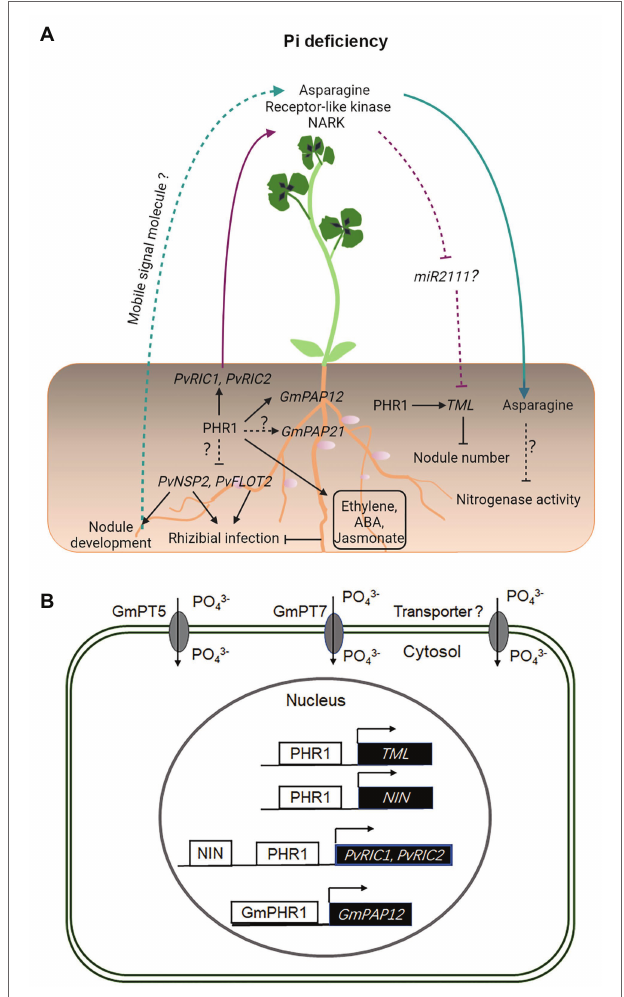
FIGURE 2 | Legume–rhizobium symbiotic signaling under inorganic phosphate (Pi) deficiency. Under Pi deficiency, the expression of PvNSP2 and PvFLOT2 is inhibited, resulting in compromised rhizobial infection and nodule development (A) . Pi deficiency induces the expression of GmPAP21 and GmPAP12 , the latter of which is directly regulated by GmPHR1 (A,B) . Pi deficiency also activates ethylene, abscisic acid (ABA), and jasmonate-related signaling processes, which inhibit rhizobial infection in Phaseolus vulgaris (A) . The expression of NIN , RIC1 , RIC2 , and TML is directly activated by PHR1 in P. vulgaris under conditions of Pi deficiency (A,B) . PvRIC1 and PvRIC2, two CLE-like peptides, negatively regulate the nodule number via the LRR-RLK, NARK-dependent AON pathway (A) . It has not been shown whether miR2111 is involved in this process (A) . Under Pi deficiency, the N-compound asparagine is significantly increased in the phloem sap and has been suggested to act as a systemic signal to inhibit the nitrogenase activity in nodules (A) . Under Pi deficiency, GmPT5 and GmPT7 are activated and function to mobilize Pi from internal and external sources to nodules (B) . Solid and dashed lines indicate the processes that are supported by experimental evidence and putative,